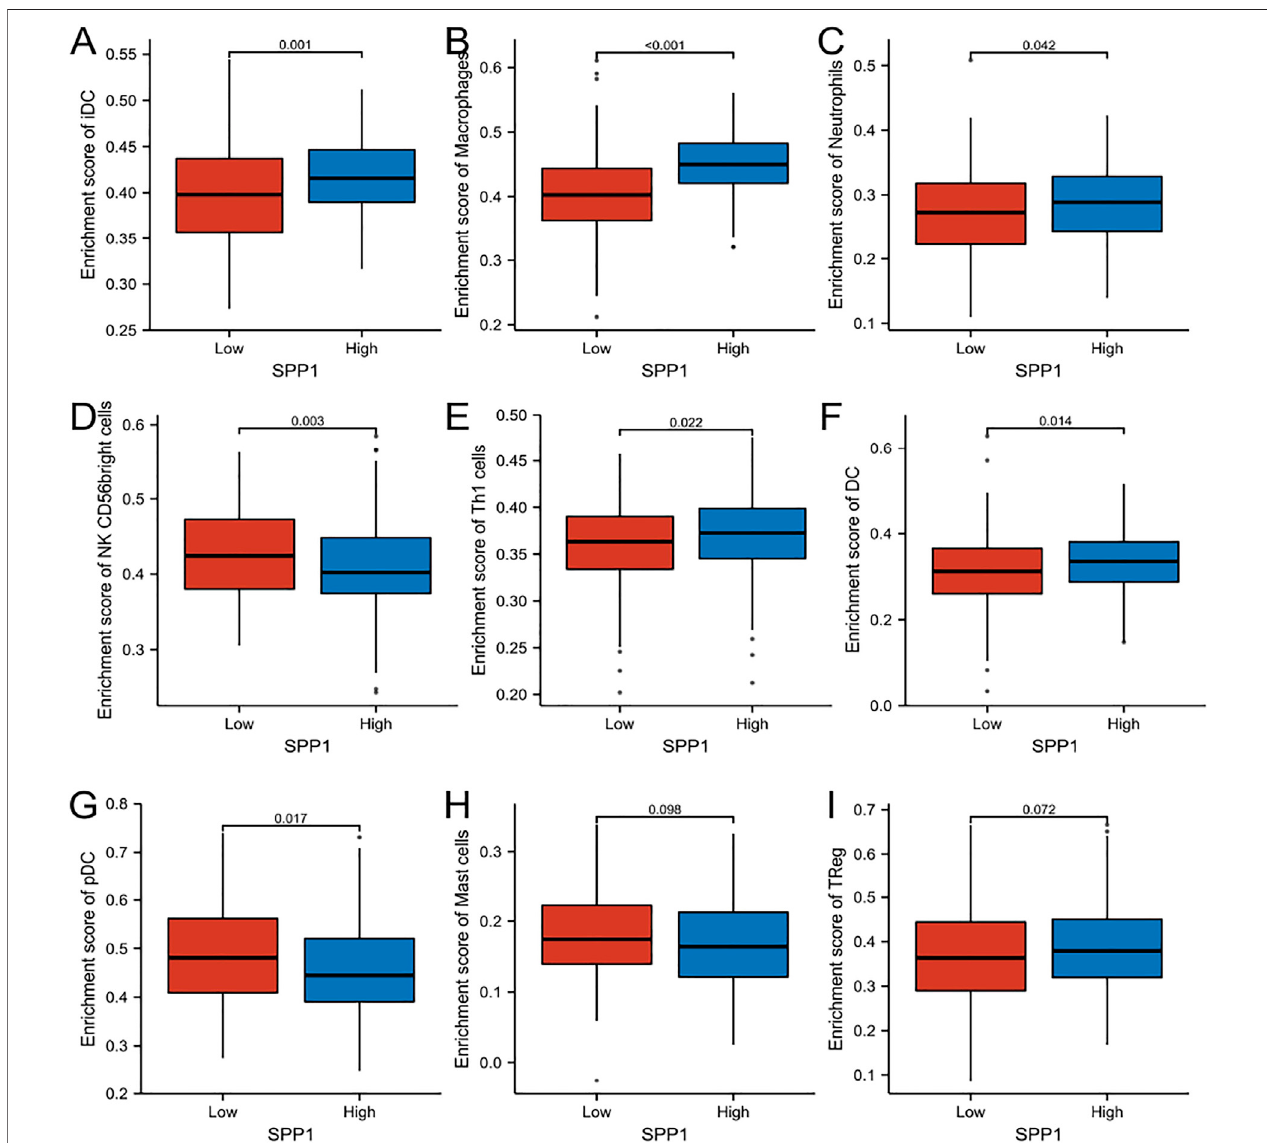
FIGURE 8 | Comparison of immune cells between high – and low – SPP1 expression groups. (A – I) Histogram showing the difference of iDC, macrophages, neutrophils, NK CD56 bright cells, Th1 cells, DC, pDC, mast cells, and Treg cell in fi ltration level between high – and low – SPP1 expression groups.